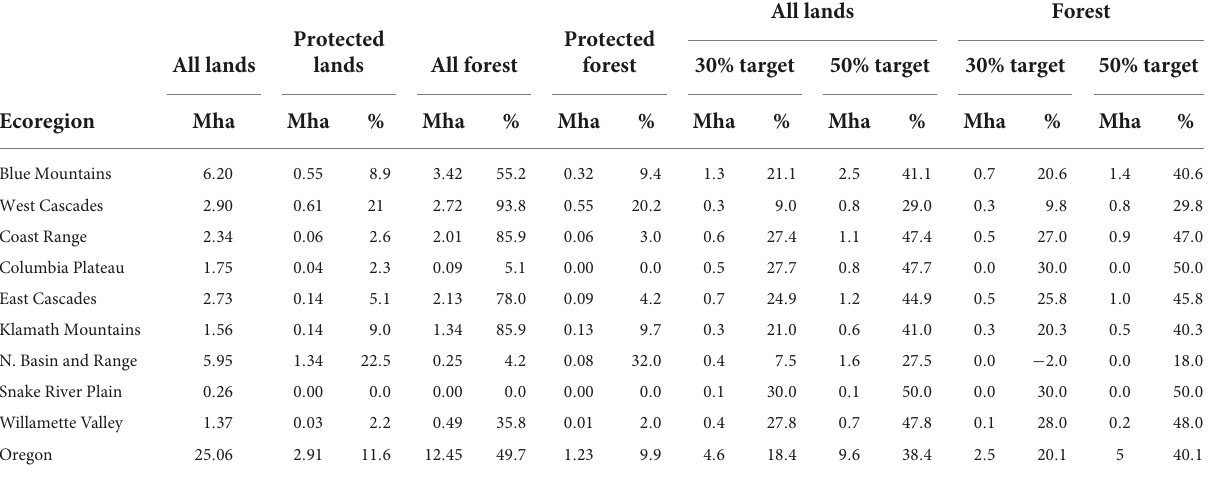
TABLE 1 Current extent of all forestlands, protected forestlands, and additional forestlands needed to meet preservation targets for each ecoregion in Oregon.